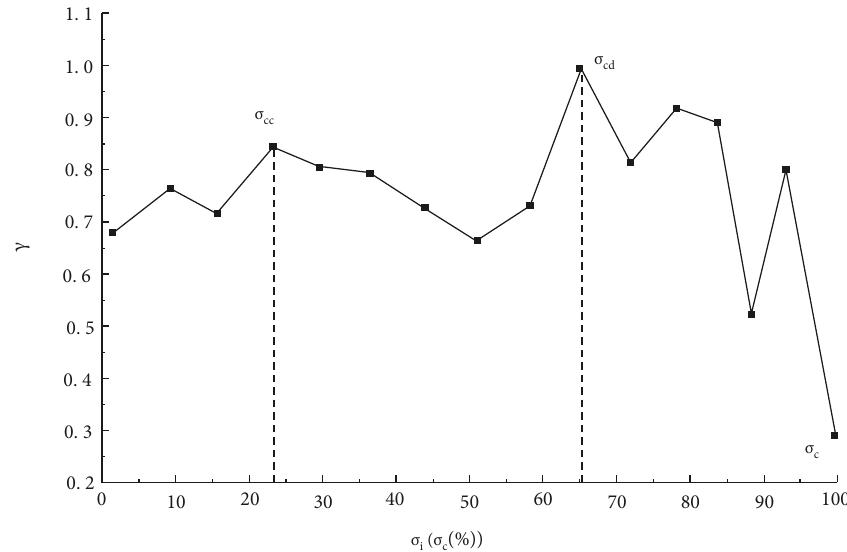
Figure 11: Variation coefficient curve of dominant frequency of received signals at different stress